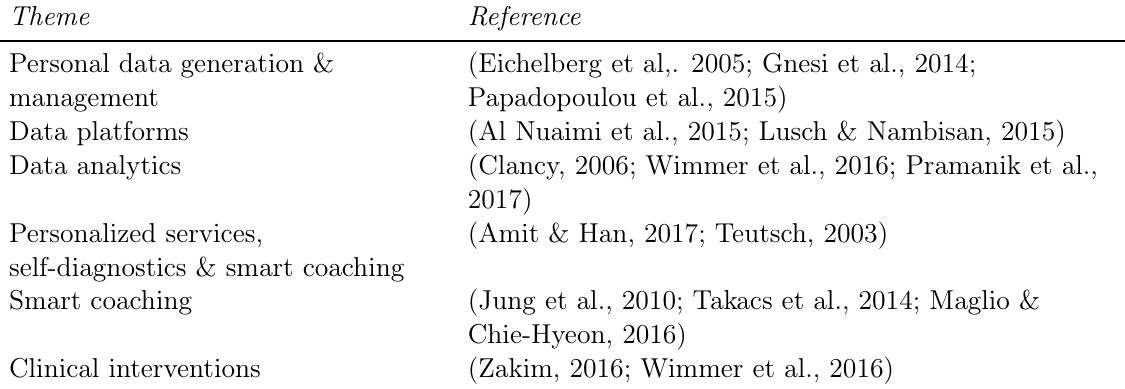
Table 1. Summary of the literature